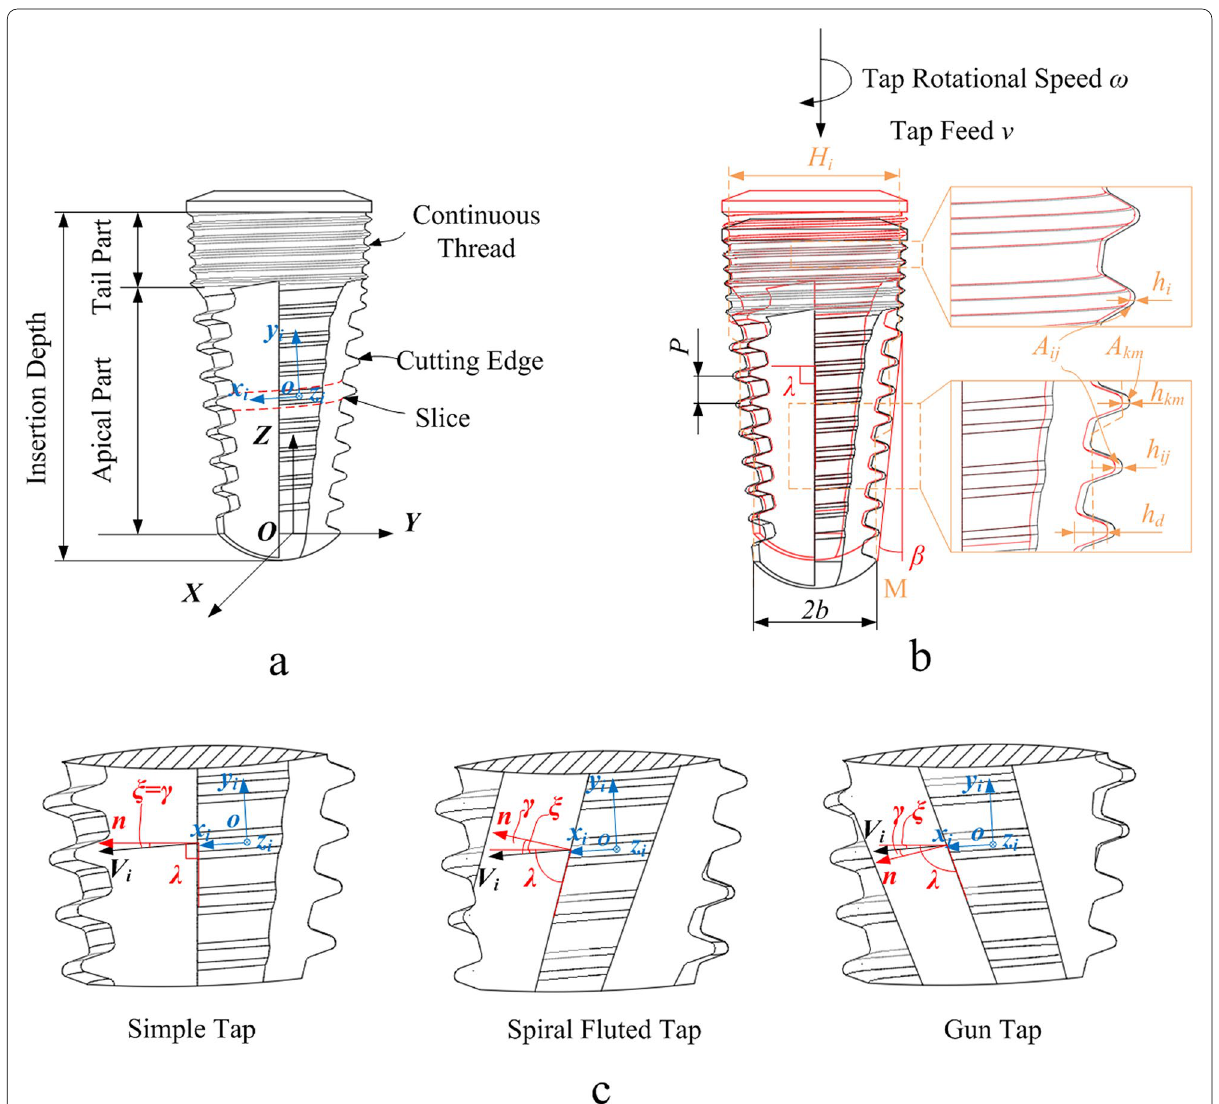
Figure 1 DIO SFR5010 and its insertion process: a the geometry of DIO SFR5010 and two coordinate systems, b geometrical parameters of DIO SFR5010 and the insertion process: initial position in red and position of one rotation cycle in black, c the relationship of angular parameters γ , ξ and